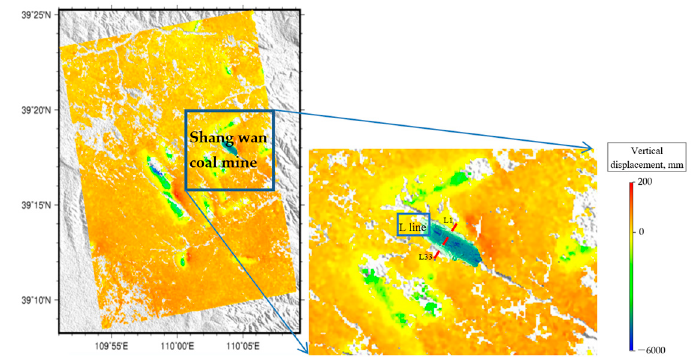
Figure 15. Surface subsidence map of working face based on InSAR and TLS data fusion.